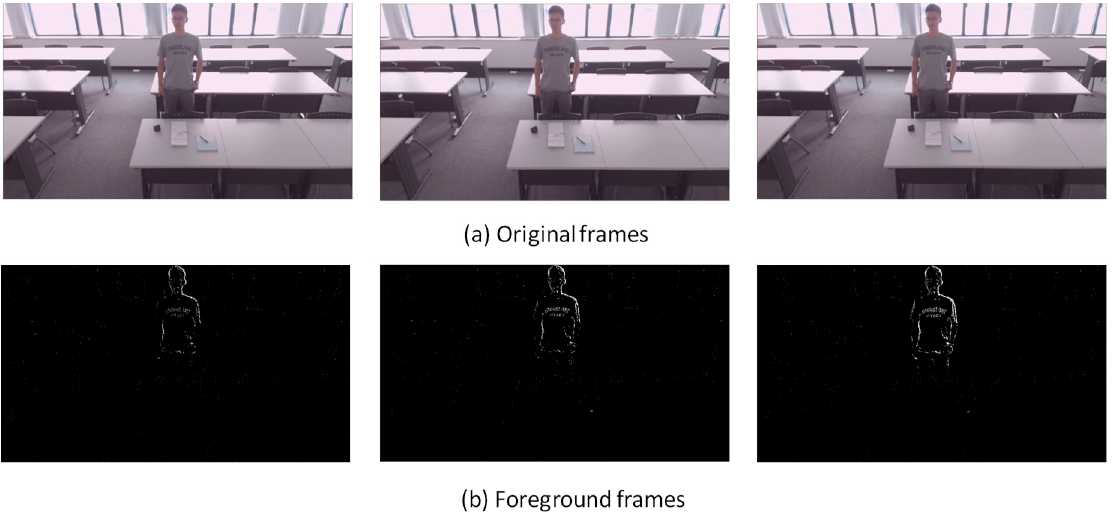
Figure 10. Walking about—sample images.